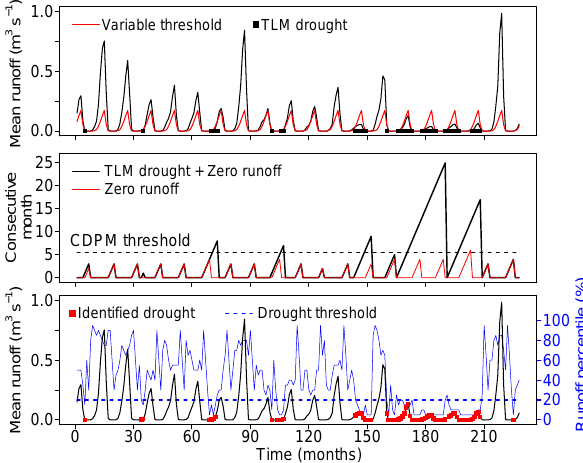
Fig. 6. Combined drought identification method using characteris- tics of both the variable TLM (Fig. 4) and the fixed CDPM (Fig. 5). The runoff series in the upper panel (black line) contains multi- ple periods with zero runoff. Within the first step, monthly varying runoff thresholds Q threshold are calculated (red line). Months for which Q> 0, Q threshold > 0 and Q ≤ Q threshold are assumed to be in a drought according to the TLM (black dots). For months with Q =0, the CDPM series (red line in middle panel) is used to obtain a given CDPM fixed threshold (dashed line in middle panel). Next, the CDPM series is combined with TLM drought series to obtain the consecutive period of being either in a drought or zero (black line in middle panel). Based on this series, dry months that exceed the CDPM threshold are also assumed to be in a drought. Bottom panel presents the final result, with the months in a drought indicated as red